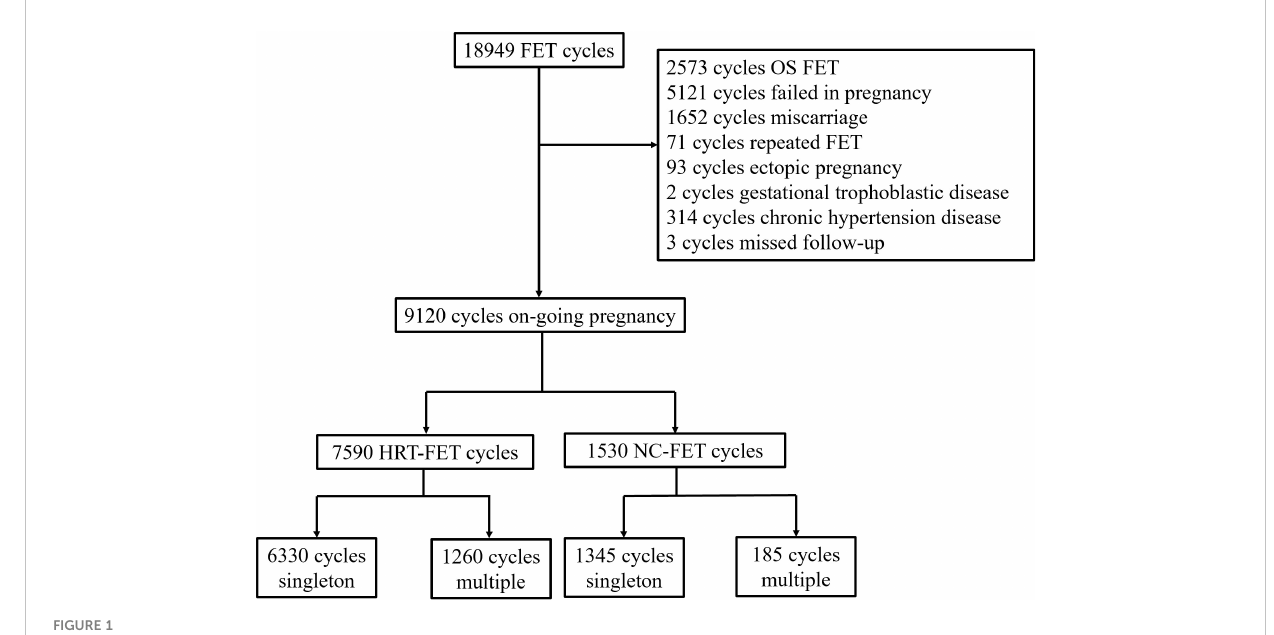
FIGURE 1 Patient selection fl